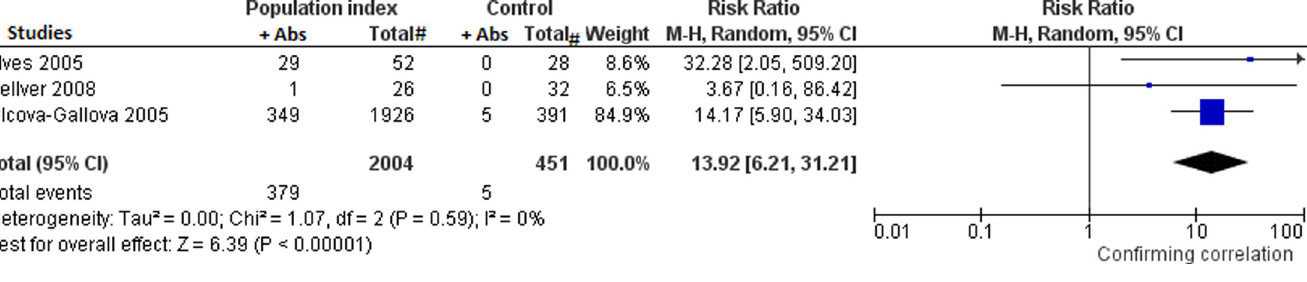
PLOS ONE | https://doi.org/10.1371/journal.pone.0260759 July 27,